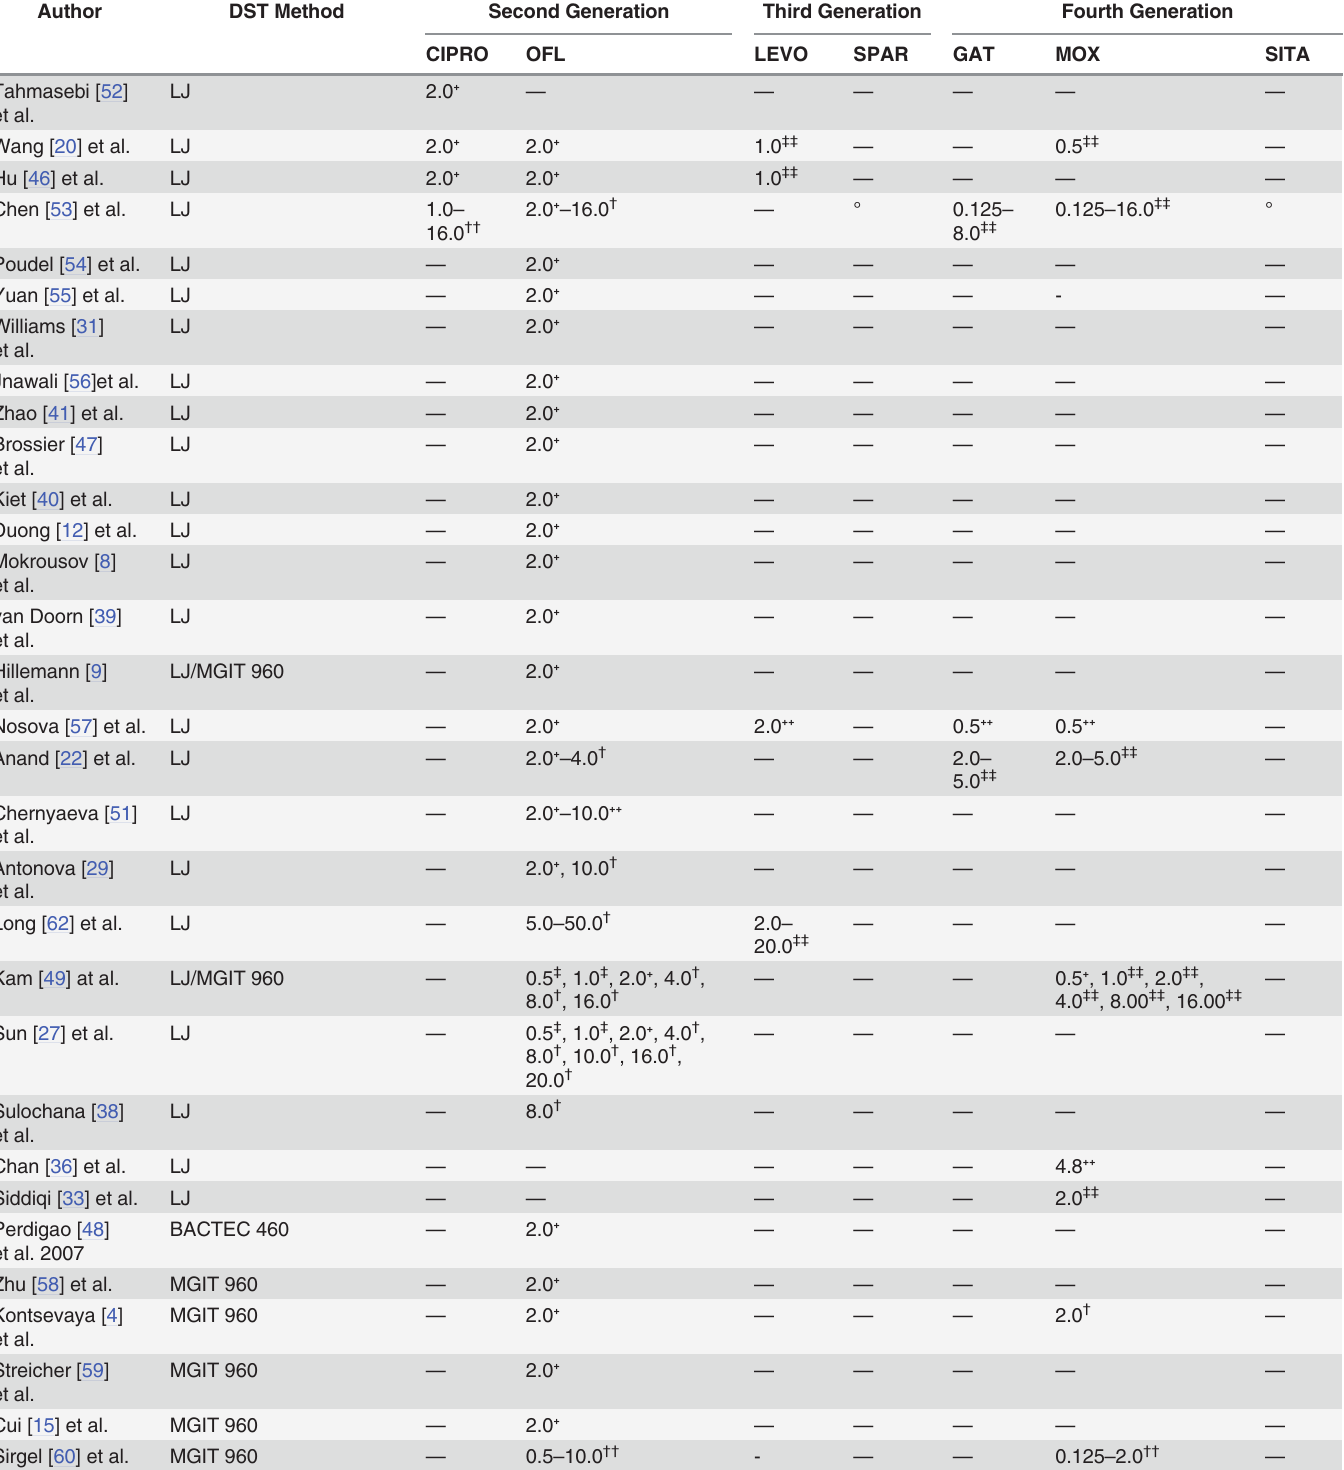
Table 2. Drug Susceptibility Testing (DST) Methods Employed in